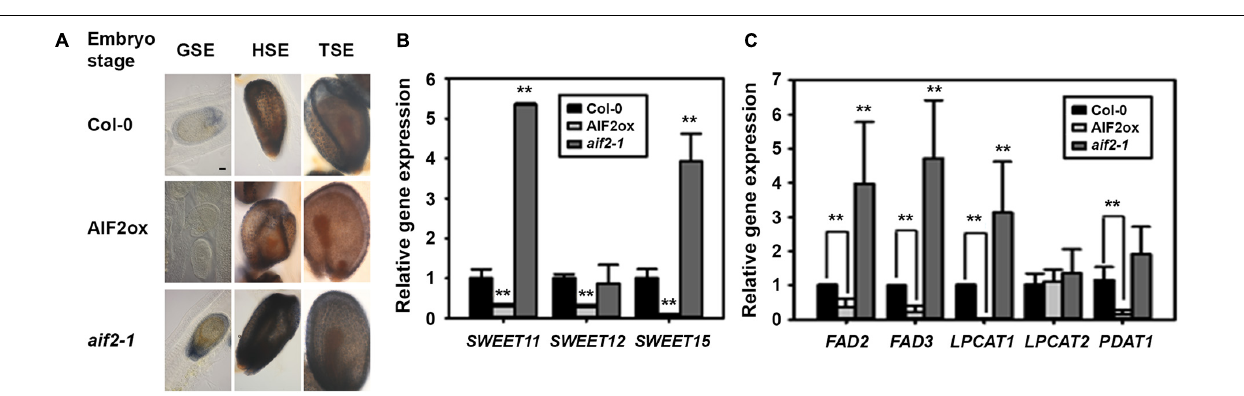
FIGURE 7 | Reduced starch and oil accumulation in seeds of AIF2 -overexpressing p35S:AIF2-EGFP (AIF2ox) transgenic plants. (A) Photographic comparison of starch accumulation in developing seeds. Siliques were stained with Lugol’s staining dye, and seeds with embryos at the same developmental stage were compared for starch accumulation. Number of seeds examined for each stage of the corresponding plants > 150. Pictures show a representative image. (B,C) Total RNA was extracted from siliques with developing seeds, and the transcript expression for sucrose transport-related genes (B) and lipid biosynthesis genes (C) was measured using qRT-PCR. Relative expression of each gene is normalised as a ratio of the Col-0 plants, which was set to 1. Statistical difference from the Col-0 control is indicated by two asterisks ( ∗∗ ) at P <